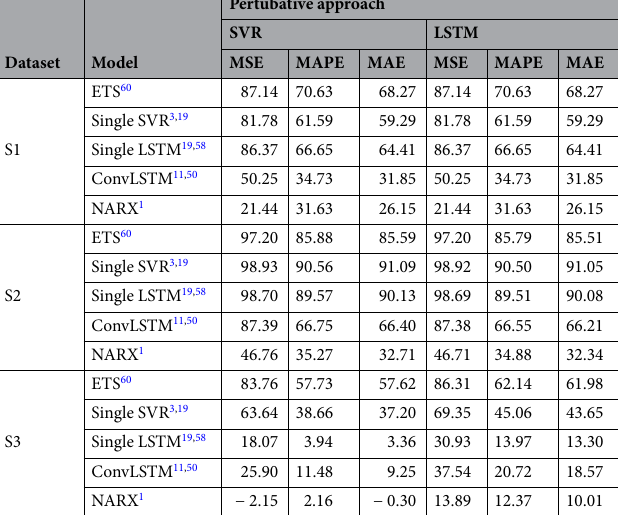
Table 5. Percentage difference between the perturbative approach and literature models for MSE, MAPE, and MAE.